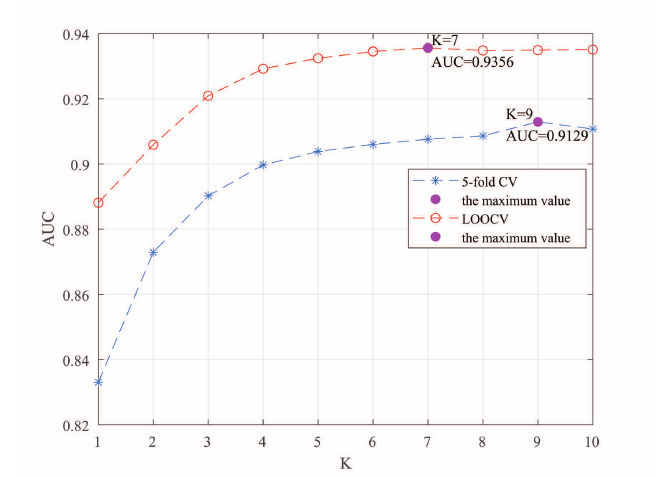
Figure 8. Sensitivity analysis of parameter K .